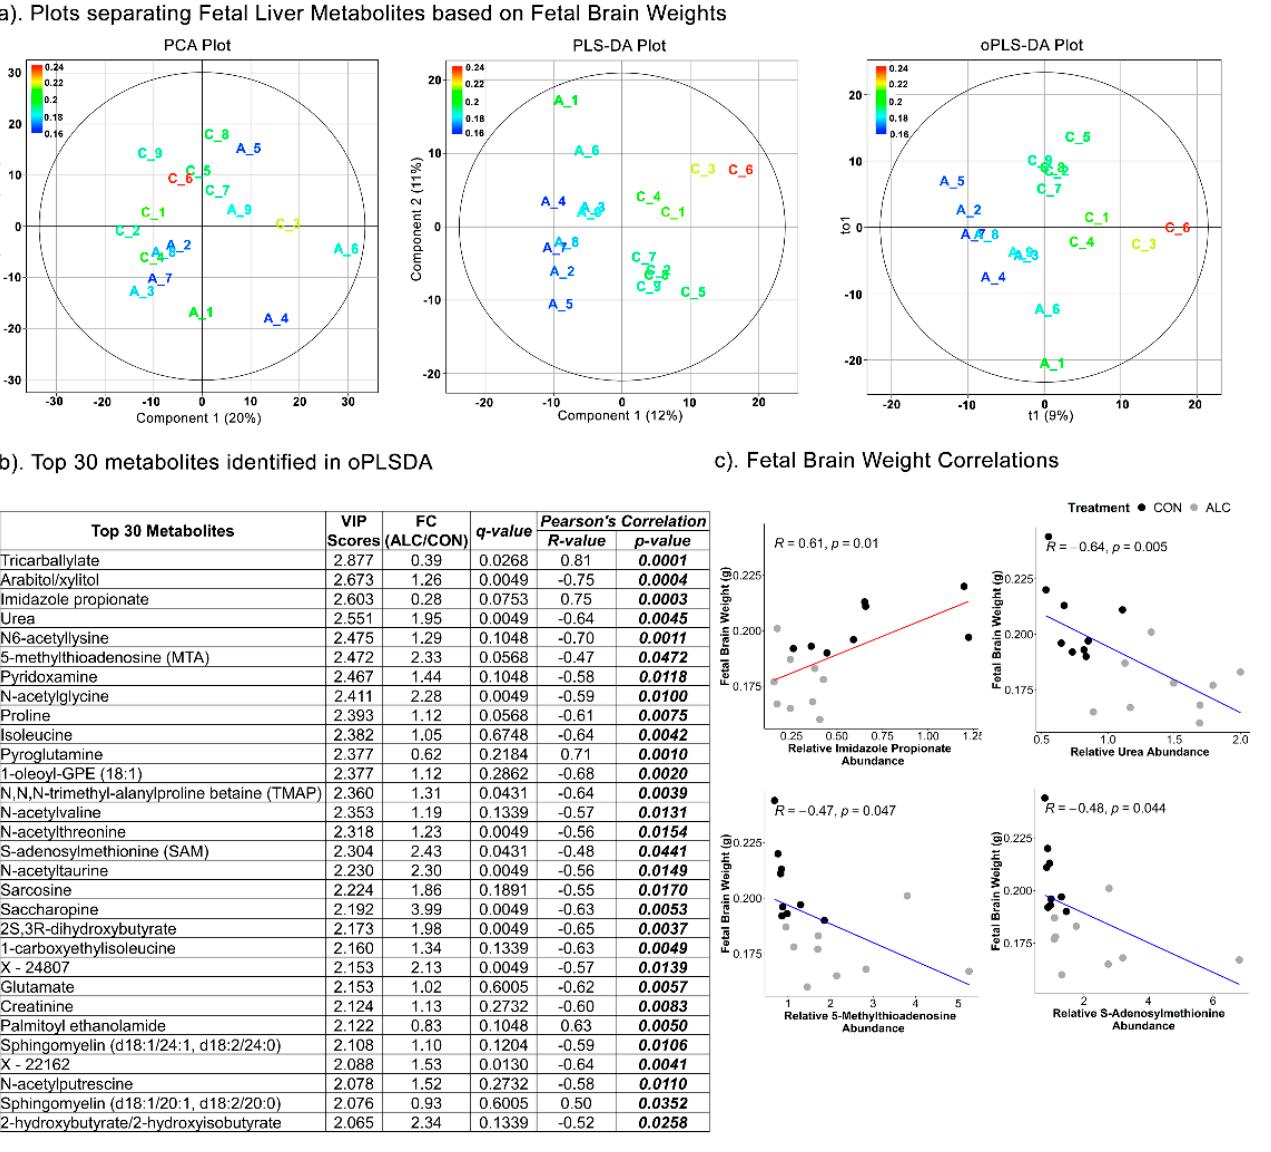
Figure 8. Separation of fetal liver metabolites as ALC vs. CON based on fetal brain weights. ( a ) PCA, PLS-DA, and oPLSDA plots depicting the separation of fetal liver metabolites as ALC vs. CON based on fetal brain weights. The legend and the corresponding color in the plots indicate increase in fetal brain weights (in g) values from blue to red. ( b ) The top 30 metabolites extracted as VIP scores in the first orthogonal component in oPLSDA with FC (ALC/CON), q-value, and Pearson’s correlation (R) analysis with respect to fetal brain weights. Significant correlations at p ≤ 0.05 are bold and italicized. ( c ) Correlation plots of top select metabolites identified in oPLSDA with fetal brain weights. The blue and red trendlines indicate significant negative and positive correlations, respectively.